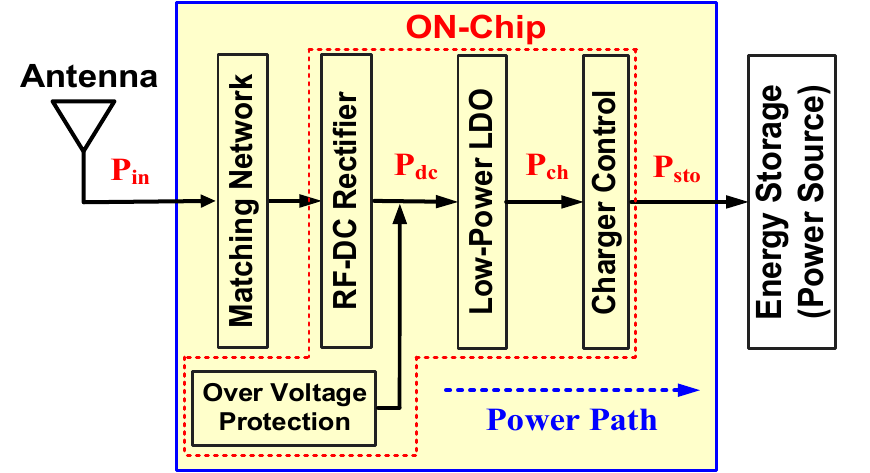
Figure 2. Functional diagram of RF-energy-harvesting IC.